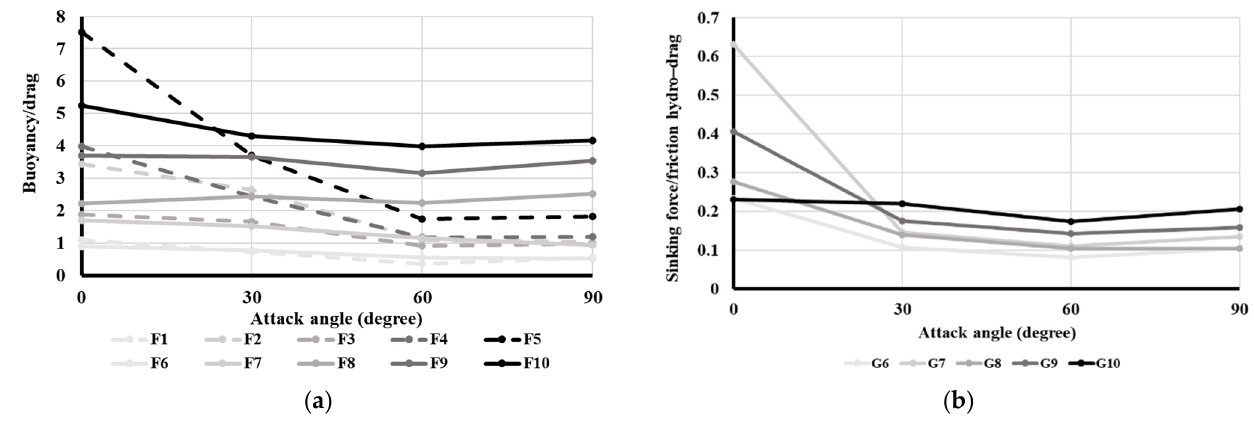
Figure 9. The relationships between ( a ) attack angle and buoyancy/hydraulic drag ratio of floats and ( b ) sinking force/hydraulic and frictional drag ratio of ground gears. ( b ) sinking force/hydraulic and frictional drag ratio of ground